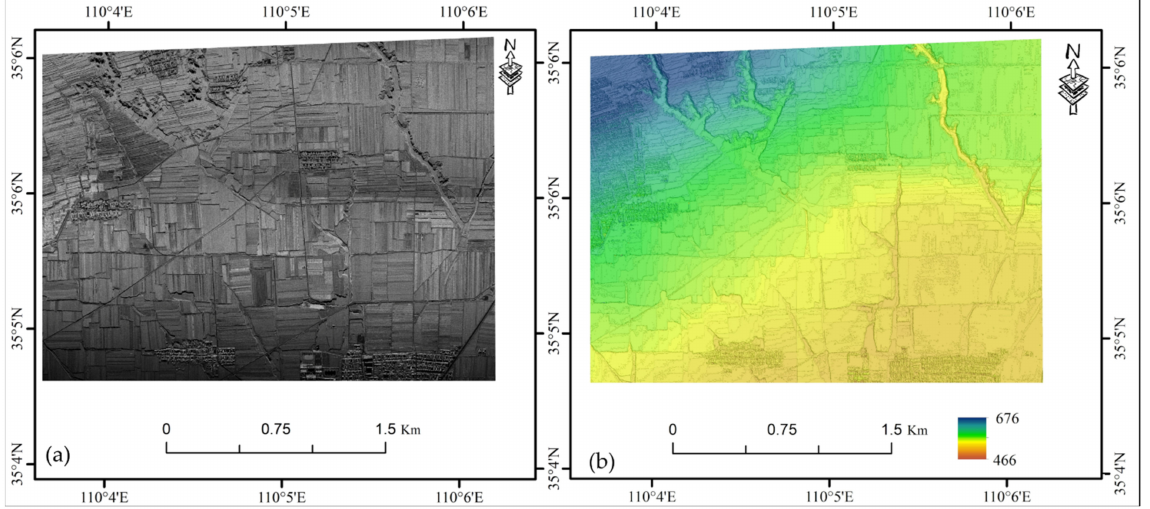
Figure 12. The obtained DOM ( a ) and DSM ( b ) of the Heyang experimental area.